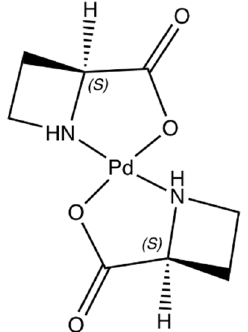
Figure 10. Molecular structure of trans -bis-(L-azetidine-2-carboxylato)palladium(II), ( 6 ).